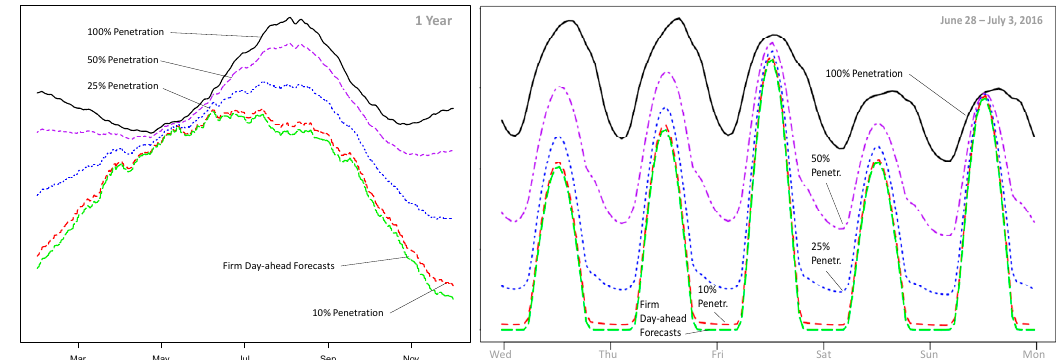
Figure 4. The evolution of the yearly ( left ) and daily ( right ) target load shape from firm forecasts to firm power generation. Notes: (1) for visual clarity, the yearly load shape presented in this figure was smoothed using a 60-day running mean to remove day-to-day variability; (2) the y-axis scales are nominal and were selected for visual clarity to better distinguish between load